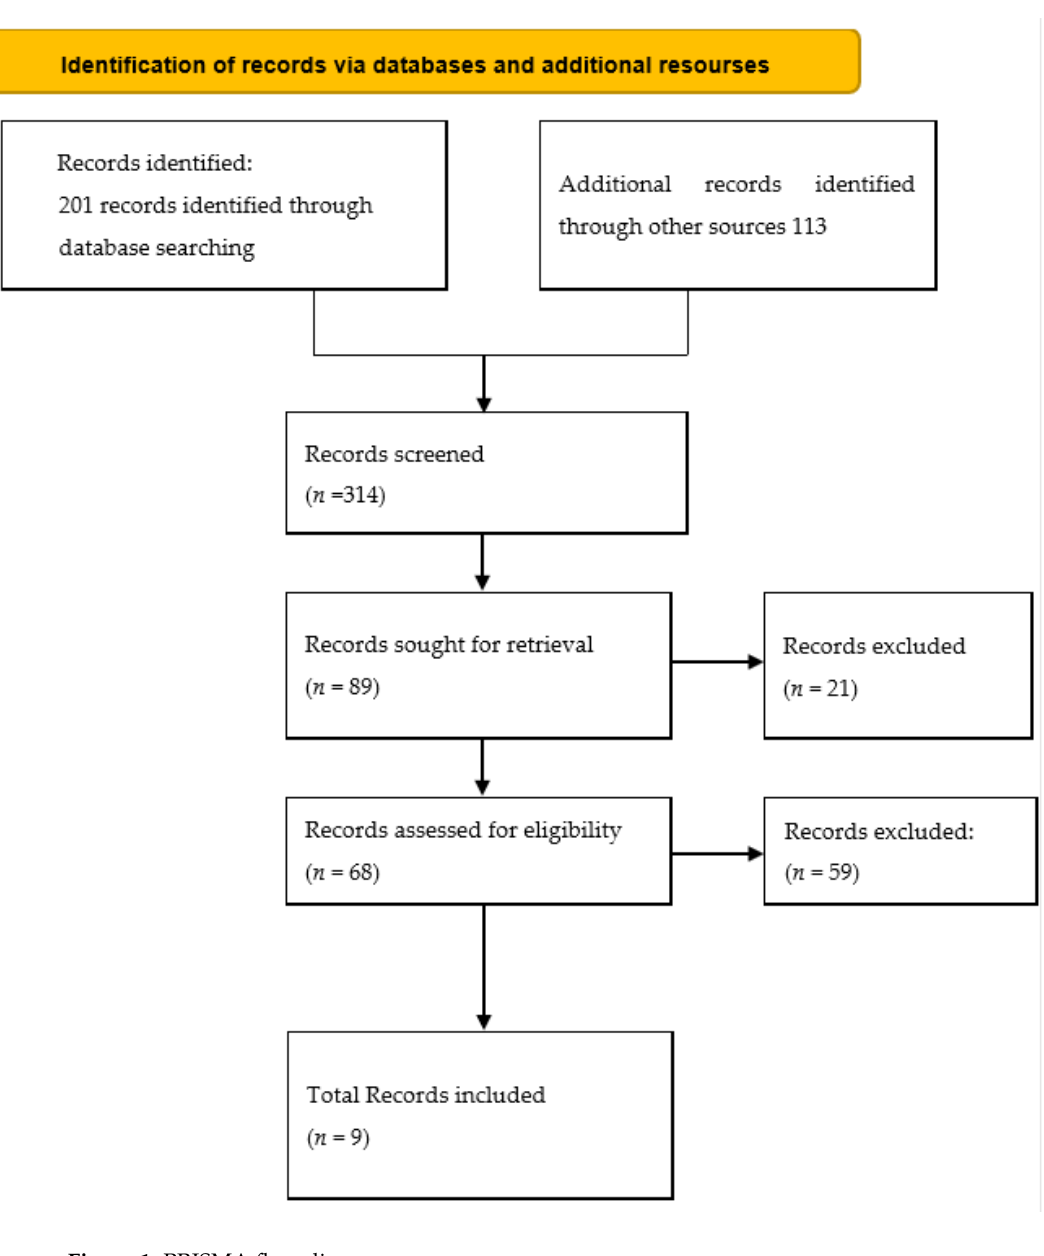
Figure 1. PRISMA flow diagram.